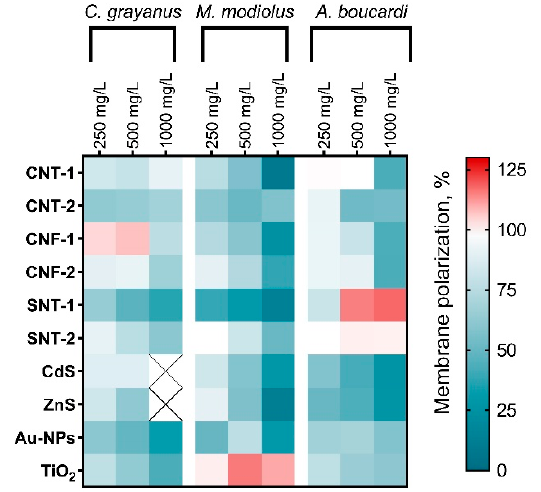
Figure 2. The changes of membrane polarization of C. grayanus , M. modiolus , and A. boucardi hemocytes after 6 h of the treatment with the NPs at concentrations of 250, 500, and 1000 mg/L. CNT, carbon nanotube; CNF, carbon nanofibers; SNT, silicon nanotube; NP, nanoparticle. For most of the tested NPs, we can notice the dose-dependent membrane depolarization. The sensitivity and reaction differed between the species and even hyperpolarization could be noted in some cases. The highest membrane depolarization under the influence of all NP samples (except TiO 2 ) was demonstrated by the hemocytes of M. modiolus at the concentration of 1000 mg/L.